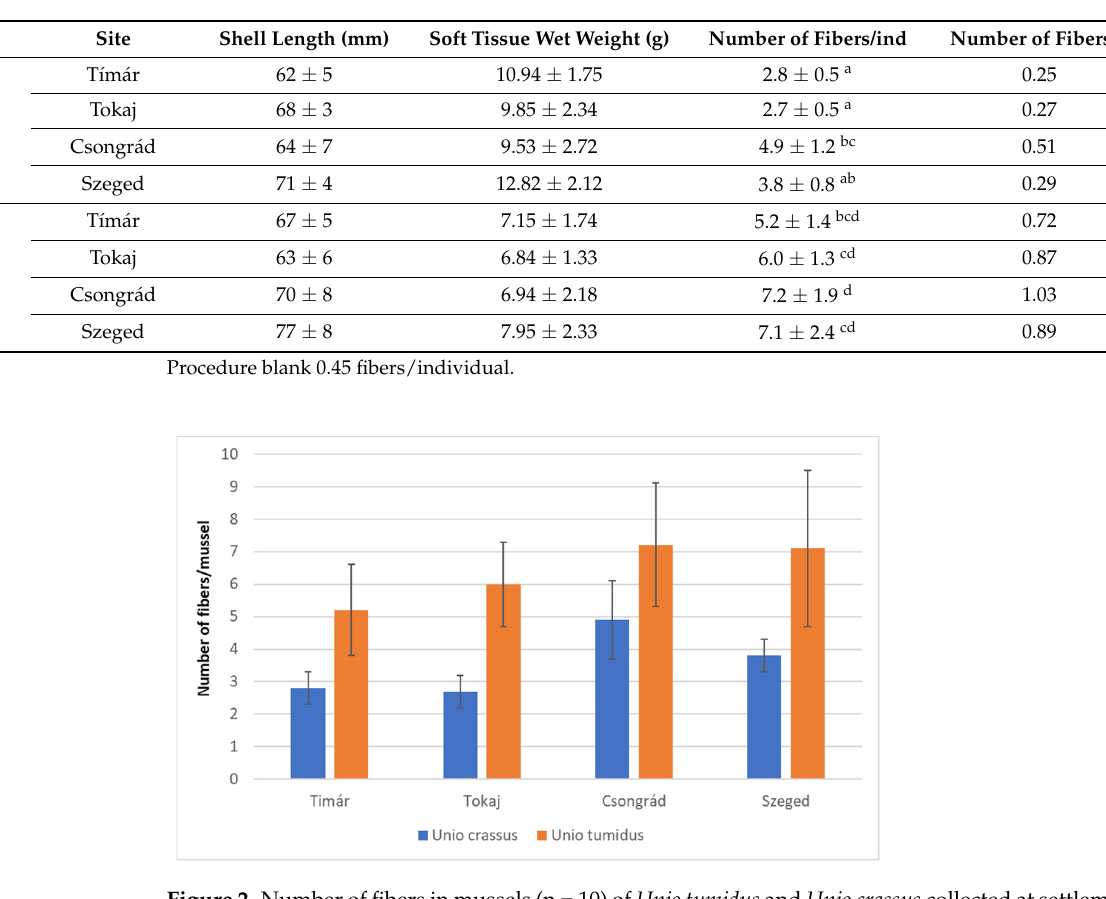
Table 2. Mean values and standard deviations of shell lengths, wet weight of soft tissues of Unio crassus and Unio tumidus mussels (n = 10), and the numbers of fibers found in these bivalves related to individuals or 1 g soft tissue. Letters (i.e., a , b , c , d ) indicate the results of the statistical analysis. Values sharing the same letters are not different significantly.